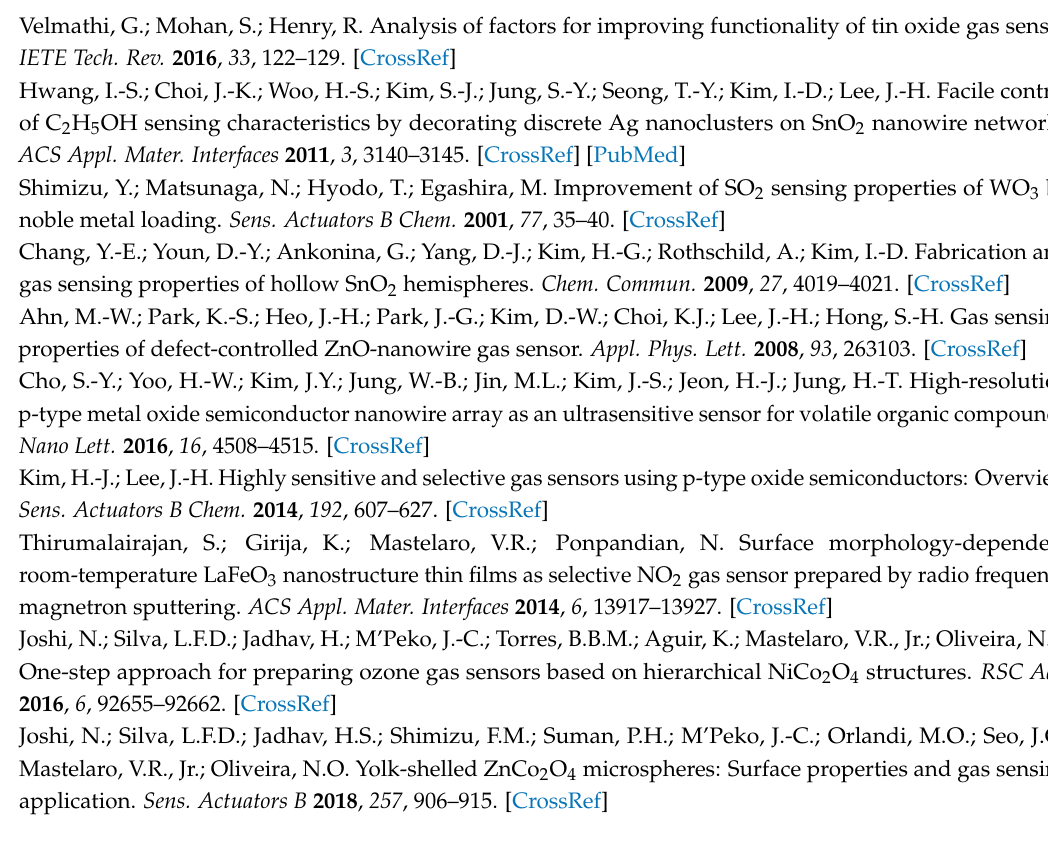
Supplementary Materials: The following are available online at http://www.mdpi.com/1424-8220/18/12/ 4438/s1, Figure S1: schematic illustrations of expected galvanic reaction process, Figure S2: scanning electron microscope (SEM) observations depending on various reaction condition, Figure S3: XRD spectrum of the Cu 2 O nanopattern before and after thermal oxidation, Figure S4: photo and SEM image of the Cu 2 O nanopattern sensors, Figure S5: elemental distribution analysis by transmission electron microscopy (TEM) - energy dispersive X-ray spectroscopy (EDS), Figure S6: the composition analysis of over-galvanic reacted sample to confirm a selective decoration property of galvanic reaction, Figure S7: schematic of the overall gas delivery system, Figure S8: response and recovery time of the Cu 2 O/Pt nanopattern sensors to 1 to 4 ppm NO 2 , Figure S9: selectivity characterization of the Cu 2 O/Pt nanopattern sensor, Figure S10: long-term stability of the Cu 2 O/Pt nanopattern sensor. Table S1: NO 2 gas sensing performance comparison based on CuO or Cu 2 O